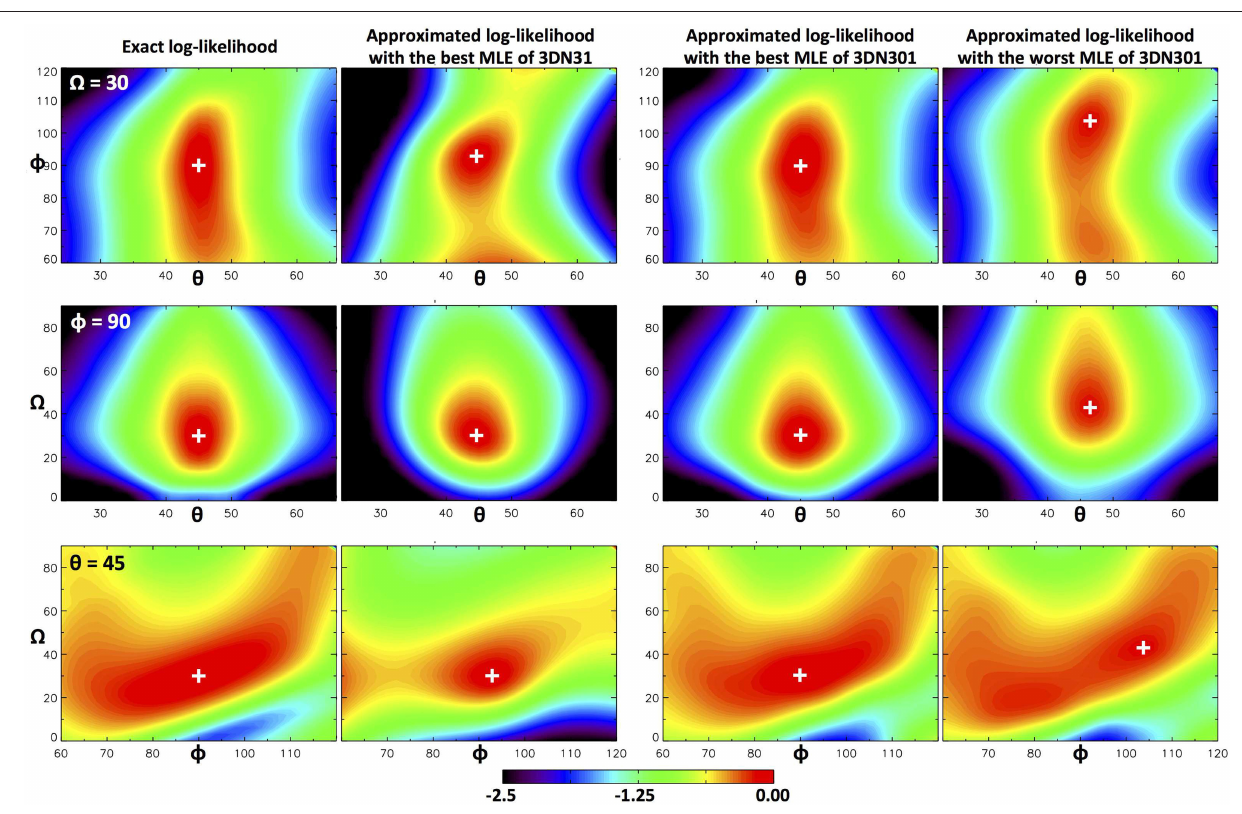
given that max( | ℓ ( x ) | ) ≈ 3.5 for the considered parameter